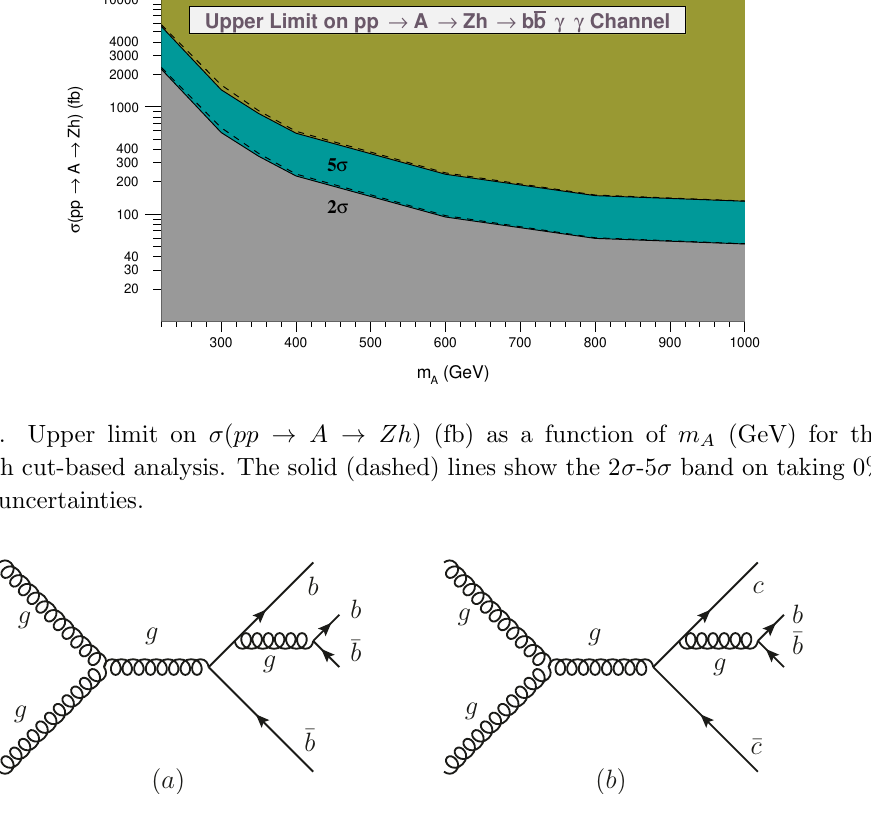
Figure 11 . Feynman diagrams for dominant (a) b (cid:22) bb (cid:22) b and (b) b (cid:22) bc (cid:22) c background for the b (cid:22) bb (cid:22) b channel.